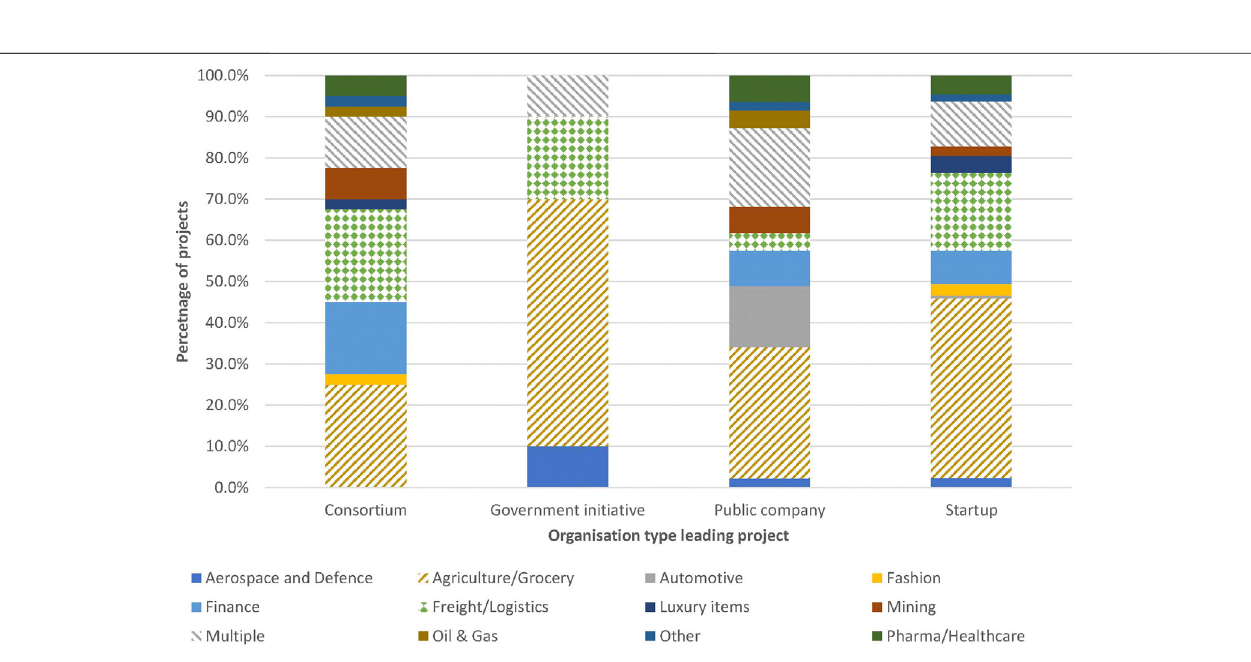
Frontiers in Blockchain |